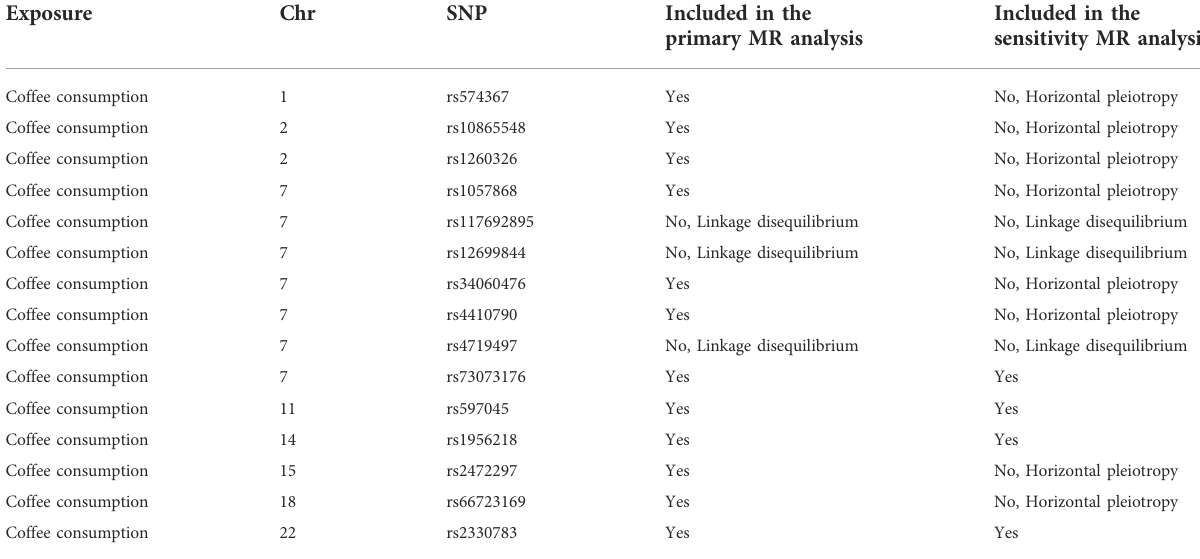
TABLE 1 Characteristics of the single-nucleotide polymorphisms associated with coffee consumption.